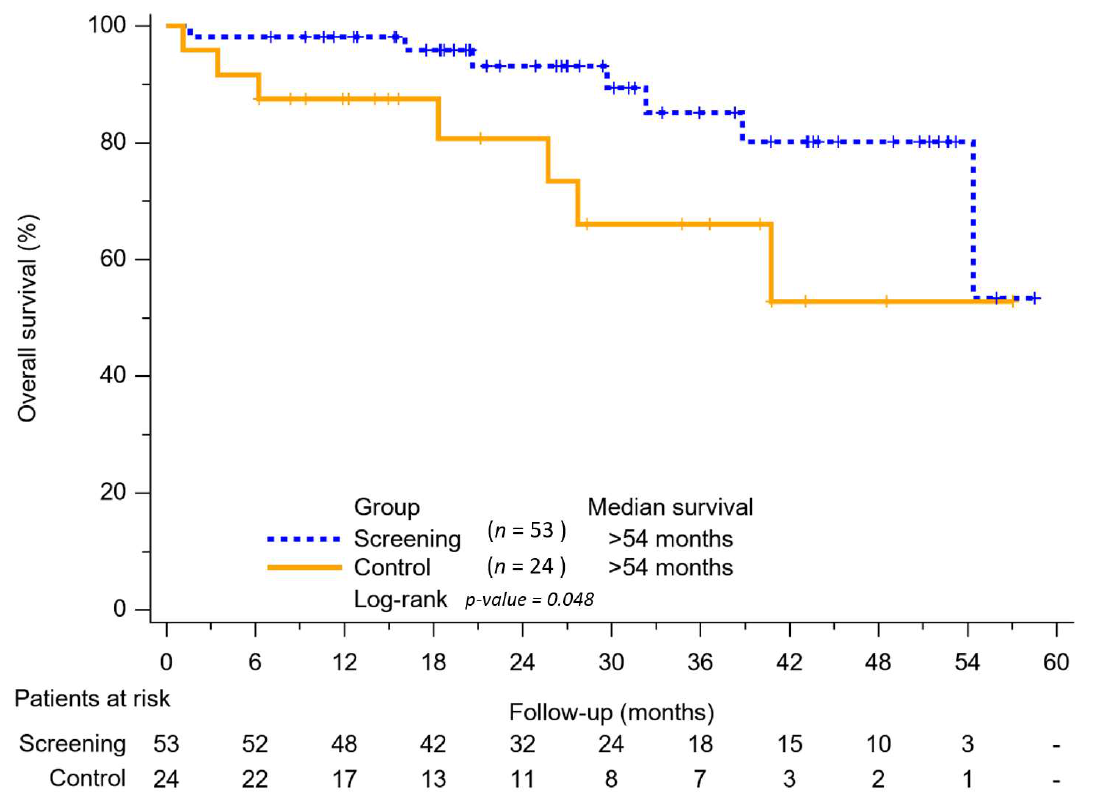
Figure 3. Kaplan–Meier analysis of overall survival between the screening group and control group.